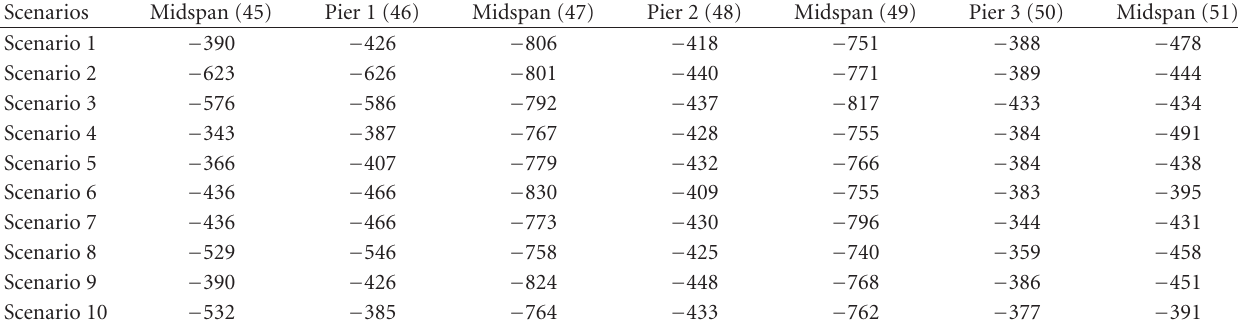
Table 9: Total stresses based on deflection measurements—south (psi ∗